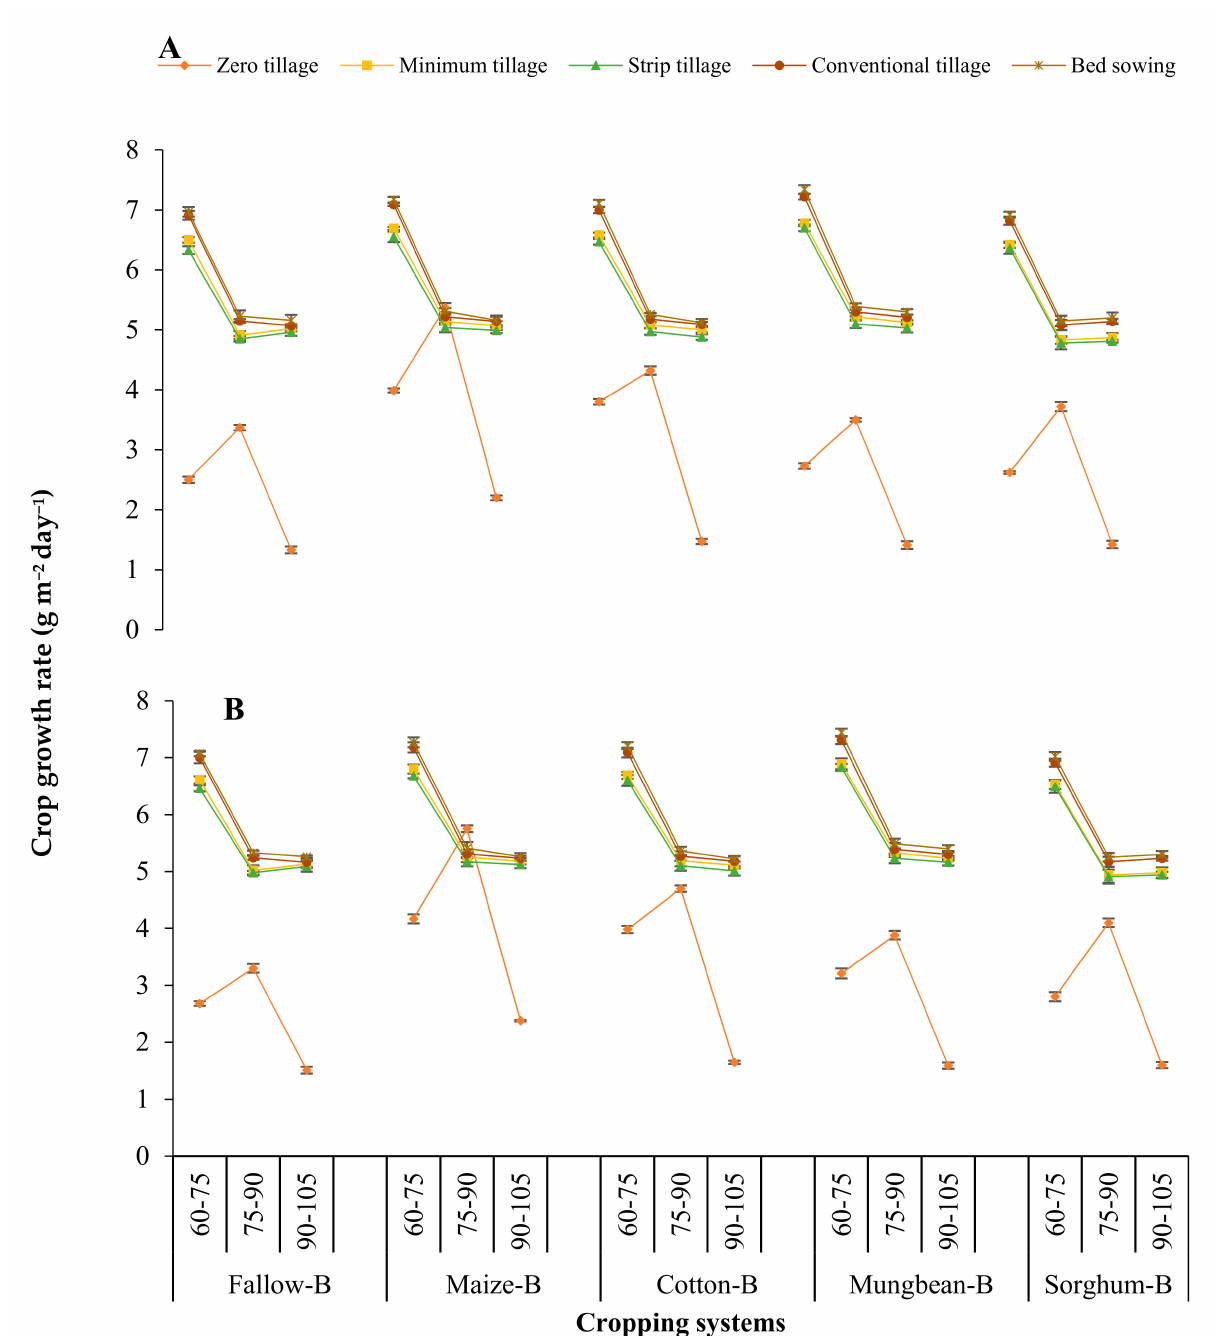
Figure 7. Interactive effect of tillage systems and barley-based cropping on crop growth rate (g m − 2 day − 1 ) of bar- ley during 2017–2018 ( A ) and 2018–2019 ( B ) ± S.E. In the legend, Fallow-B = Fallow-barley, Maize-B = Maize-barley, Cotton-B = Cotton-barley, Mungbean-B = Mungbean-barley and Sorghum-B =